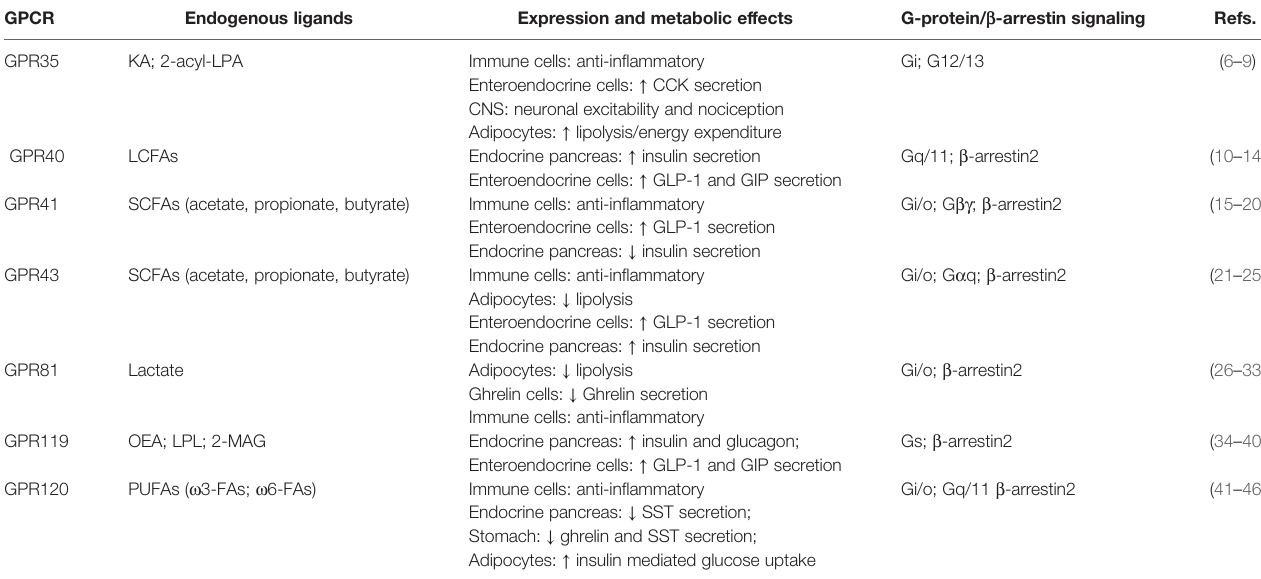
TABLE 1 | Selection of GPCRs and their endogenous agonists act as signaling molecules.